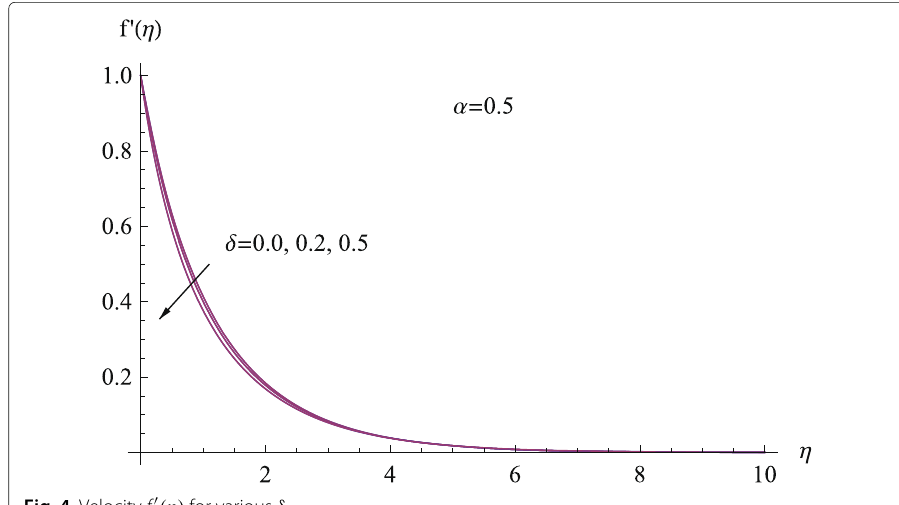
the fluid which having less thermal conductivity was placed down the curve with more thermal conductivity, which means that a large ε value induces more progress in the distribution of the temperature inside the thermal region. On the other hand, Fig. 6 indi- cates that the tested heat pattern through the parameter ε was primarily affected by the Williamson fluids having variable conductivity. Further, thermal thickness and distribu- tion of temperature with great radiation parameter R are larger than those of distribution and thermal thickness with small radiation parameter R as shown in Fig. 7.